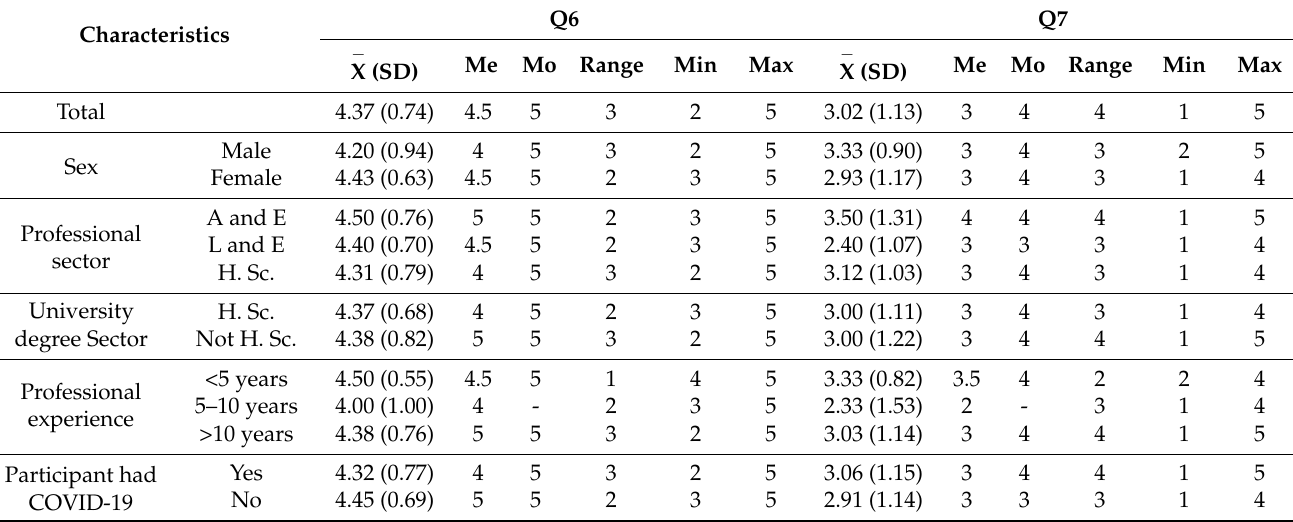
Table 5. Centrality and dispersion in Likert type questions 6 and